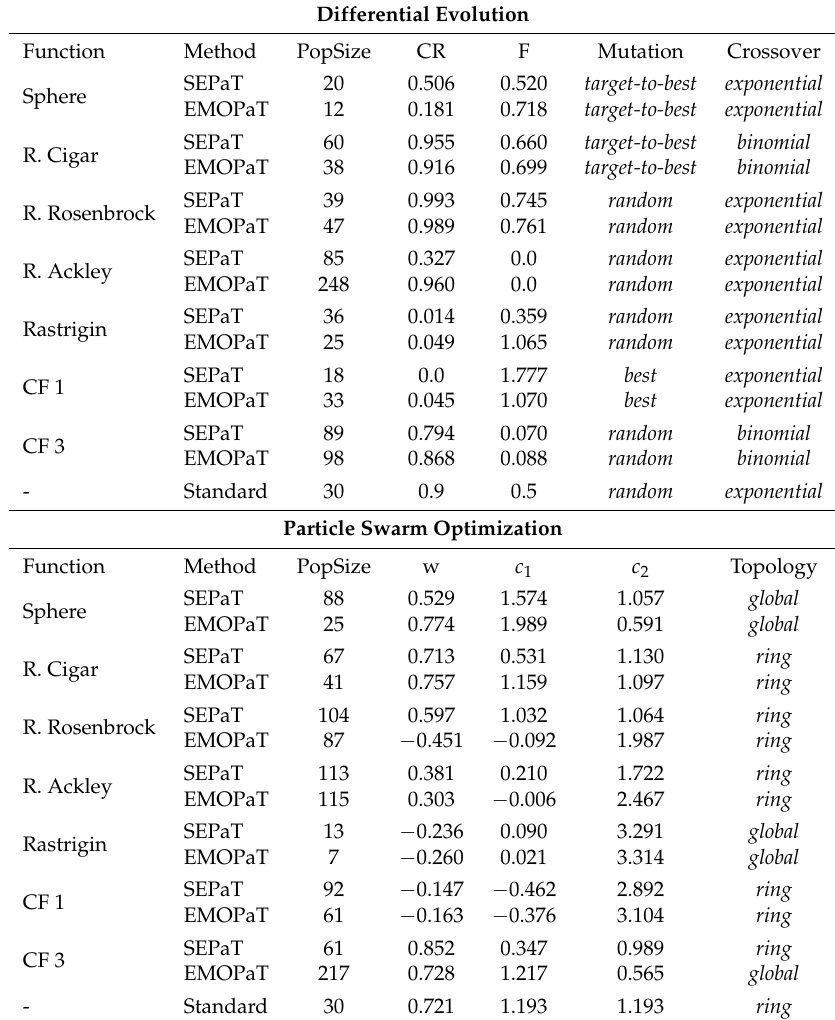
Table A2. Best-performing parameters obtained over 10 runs of EMOPaT and SEPaT, and standard settings for PSO ([42]) and DE ([11]).